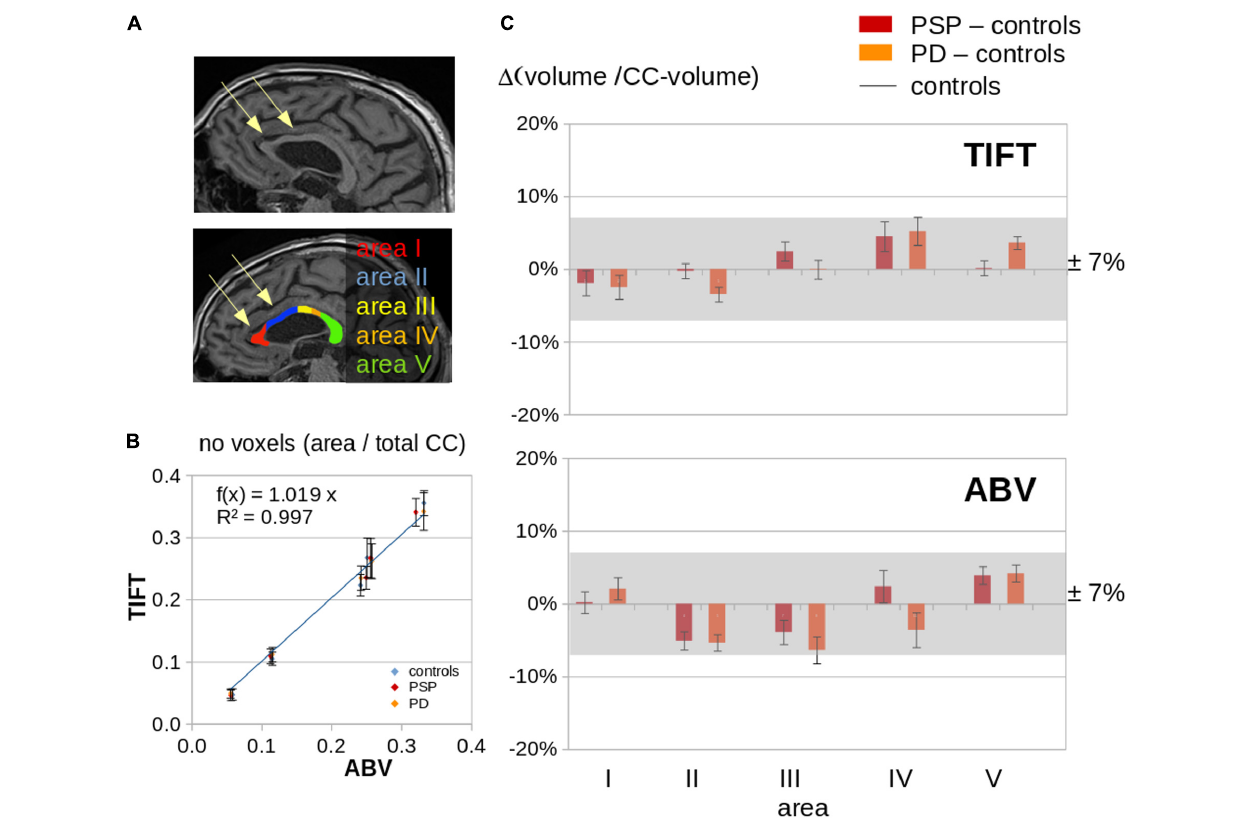
FIGURE 1 | ABV and planimetry (TIFT) for the subject groups. (A) Examples of a PSP patients with visually apparent regional volume alterations in callosal areas I and II and the respective CC segmentation. (B) Association of ABV and planimetry (TIFT) results for subject groups controls, PSP, and PD, separated into callosal areas; number of voxels were provided as ratio of number of voxels in the respective callosal area and the total number of voxels in the CC. (C) Comparison of ABV and planimetry (TIFT) results of PSP and PD patients and controls; “volume/CC-volume” means the ratio of number of voxels in the respective callosal area and the total number of voxels in the CC. Results of PSP patients and PD patients were normalized to the average callosal area of controls (“PSP – controls” and “PD – controls”).